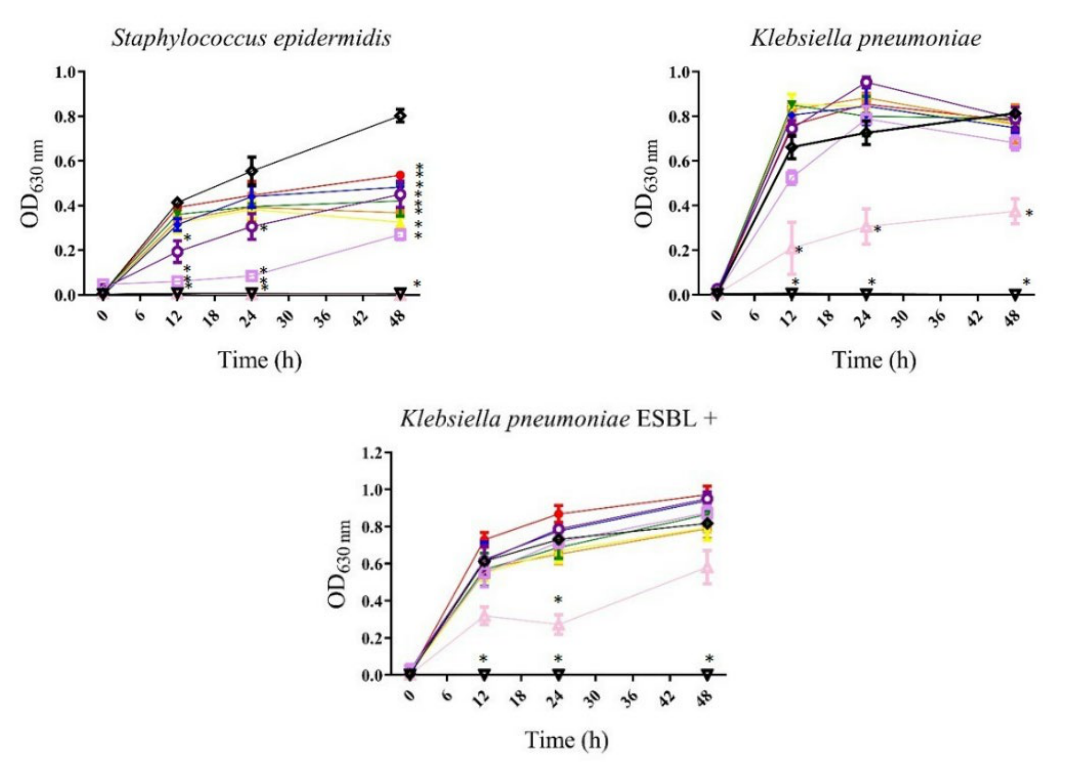
Table 3. Growth-inhibitory activity of algae extracts or compounds against different Gram-positive and Gram-negative bacteria. * Concentration in µg/mL; (a) : resistant bacteria; —: no MIC 50 or MIC 90 reached at 400 µg/mL; ESBL+: extended spectrum beta-lactamase.